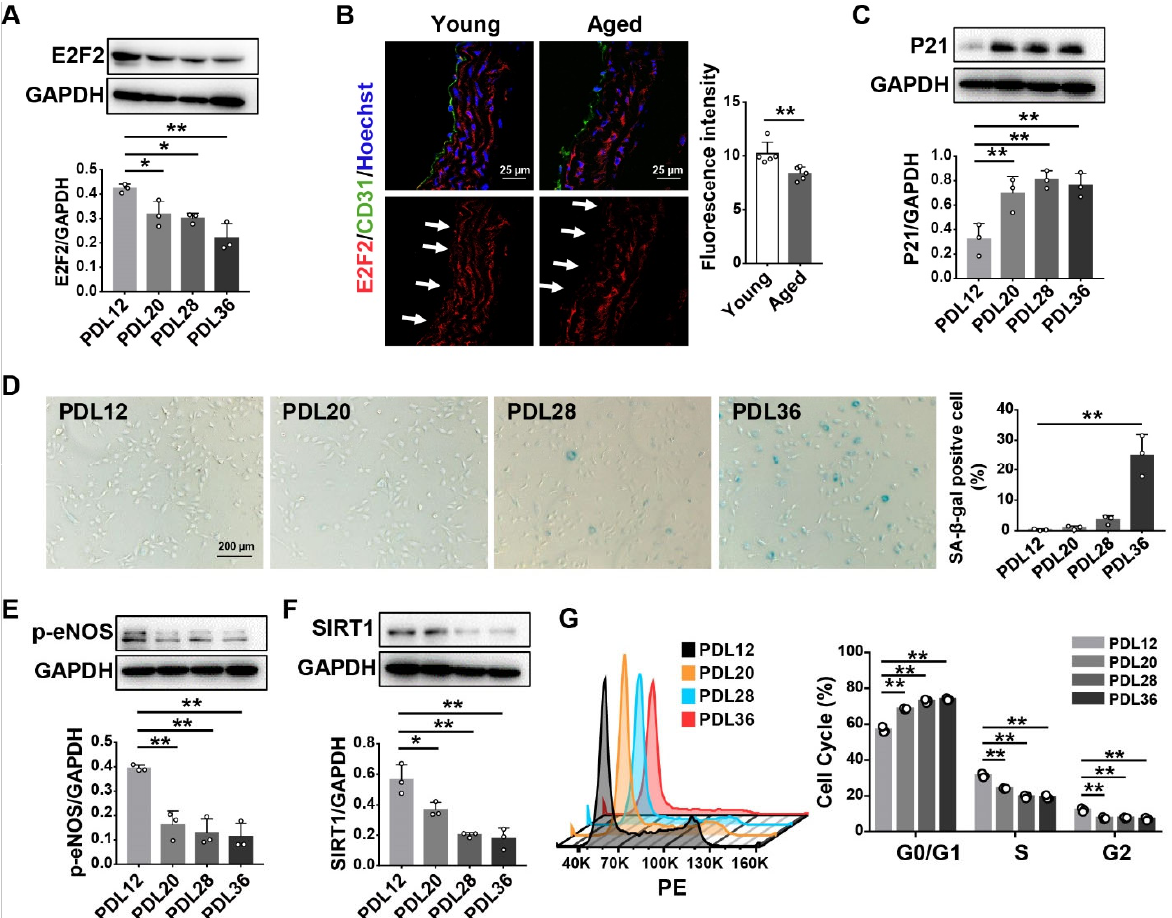
Figure 1. Decreased E2F2 expression in senescent HUVECs and in the aortas of aged mice. ( A ) E2F2 expression in HUVECs with different PDLs by Western blotting. Protein levels, normalized to GAPDH, were estimated by densitometry. Statistical analysis was performed with one ‐ way ANOVA. ( B ) Immunofluorescent staining for E2F2 (red), CD31 (green), and nuclei (blue) in frozen aorta sections from young mice (3 months, n = 5) and aged mice (15 months, n = 5). Scale bar: 25 μ m. Arrows indicate endothelium. Statistical comparison of mean fluorescent intensity was performed by Student’s t test. ( C ) Protein expression of P21 in HUVECs with different PDLs. ( D ) SA ‐β‐ gal staining (blue) for HUVECs with different PDLs. Scale bar: 200 μ m. One ‐ way ANOVA for a comparison of the percentage of SA ‐β‐ gal ‐ positive cells. Protein expression of p ‐ eNOS ( E ) and SIRT1 ( F ) in HUVECs with different PDLs. ( G ) Cell cycle analysis for HUVECs with different PDLs. Statistical analysis was performed with two ‐ way ANOVA. Values are mean ± S.D. * p < 0.05, ** p < 0.01.